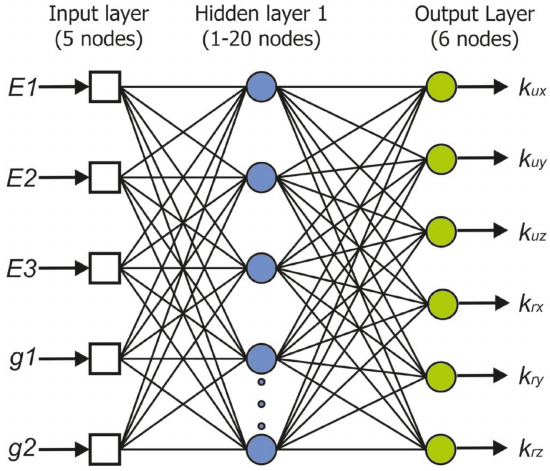
Figure 6. Characteristics of the ANN